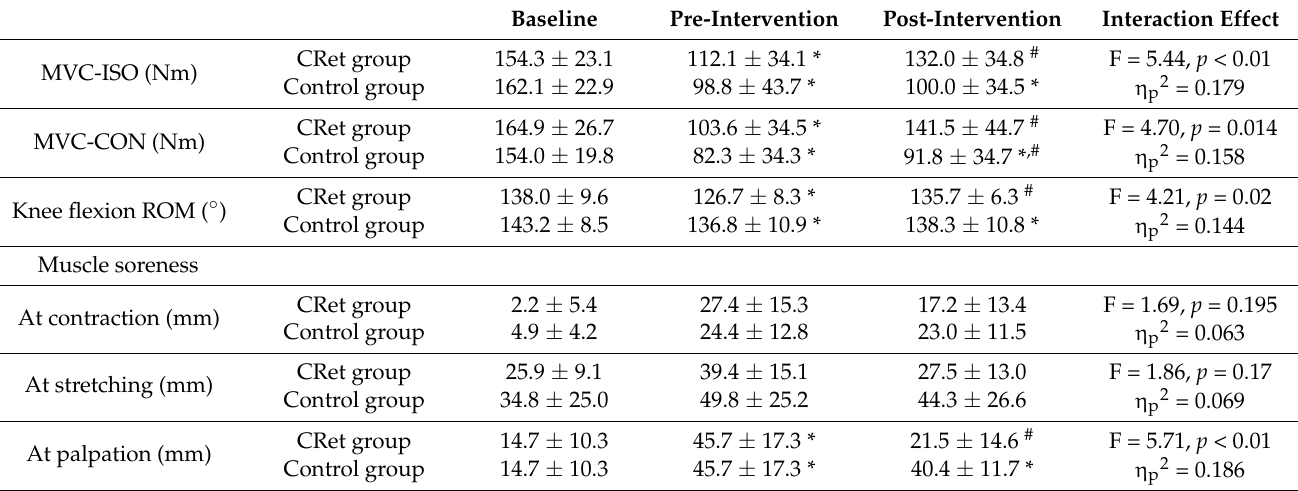
Table 1. The changes in maximum voluntary isometric contraction (MVC-ISO), maximum voluntary concentric contraction (MVC-CON) torque of the knee extensors, knee flexion range of motion (ROM), and muscle soreness at contraction, stretching, and palpation in capacitive and resistive electric transfer (CRet) intervention and control groups. Baseline Pre-Intervention